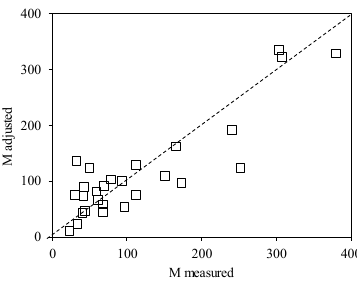
Figure 10. Goodness of adjustment of the erosion rate ( M ) parameter for the shear stress-based model.